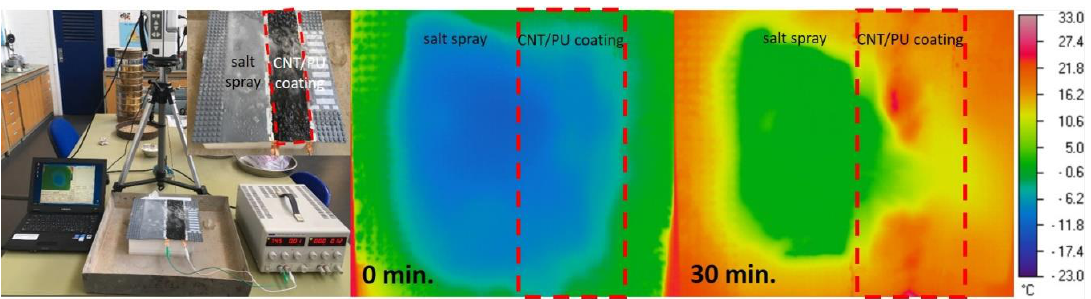
Figure 7. Example of Joule heating application.